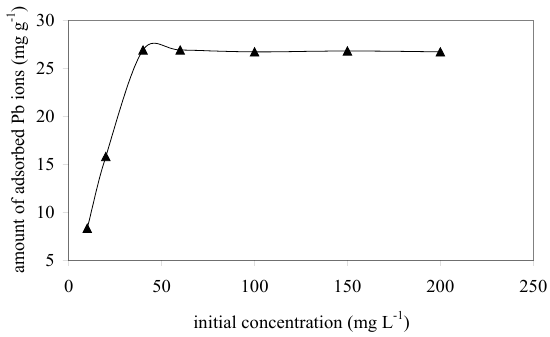
Figure 4. Adsorption of Pb(II) on the support studied; pH 6.0, T 298